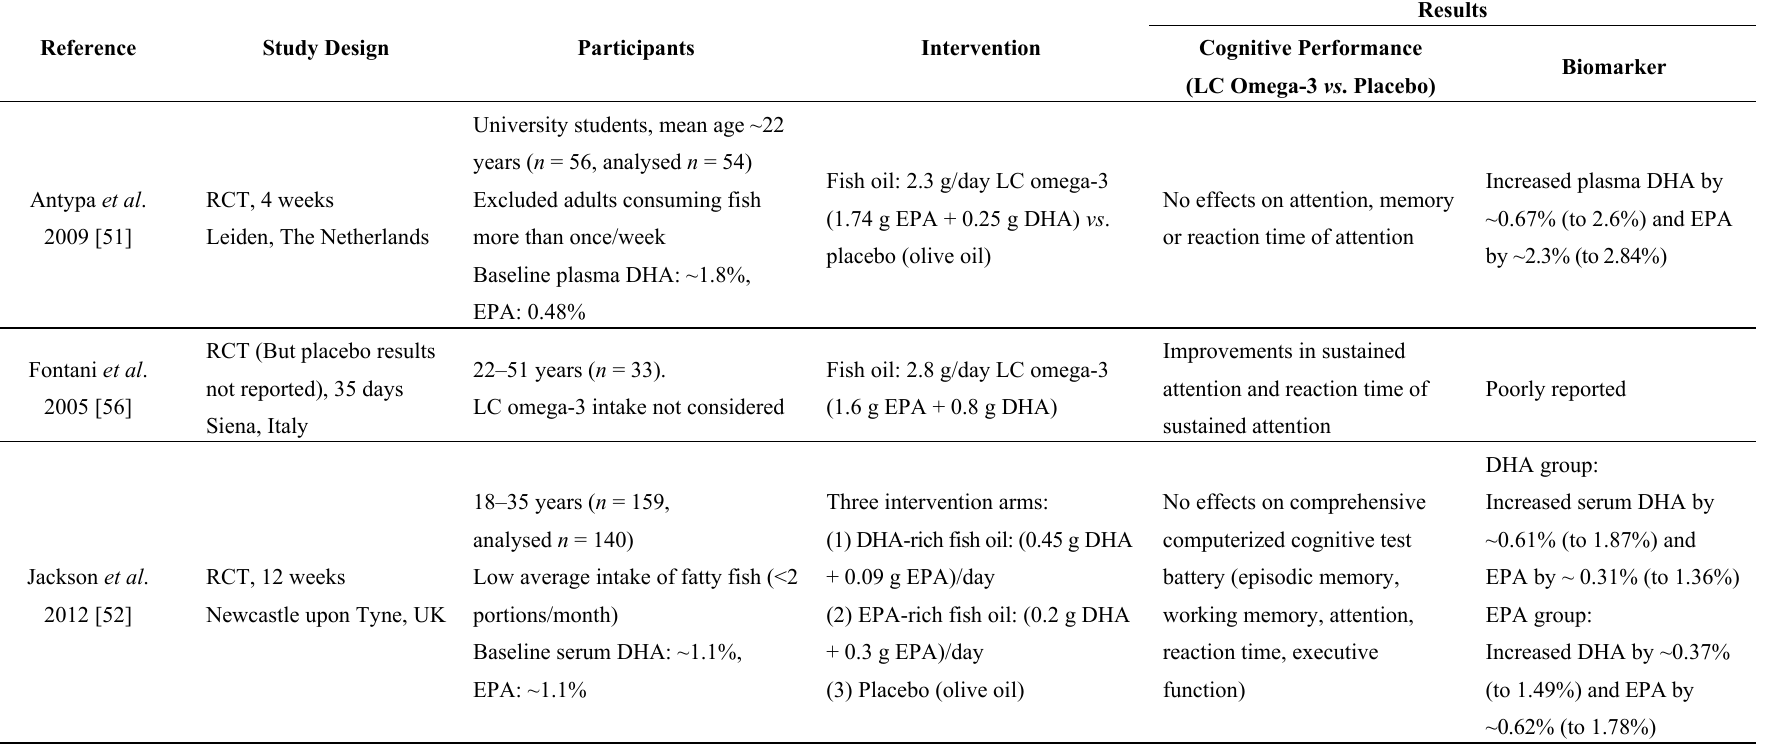
Table 2. Nutrition intervention trials of long-chain omega-3 PUFA and cognitive function in healthy younger